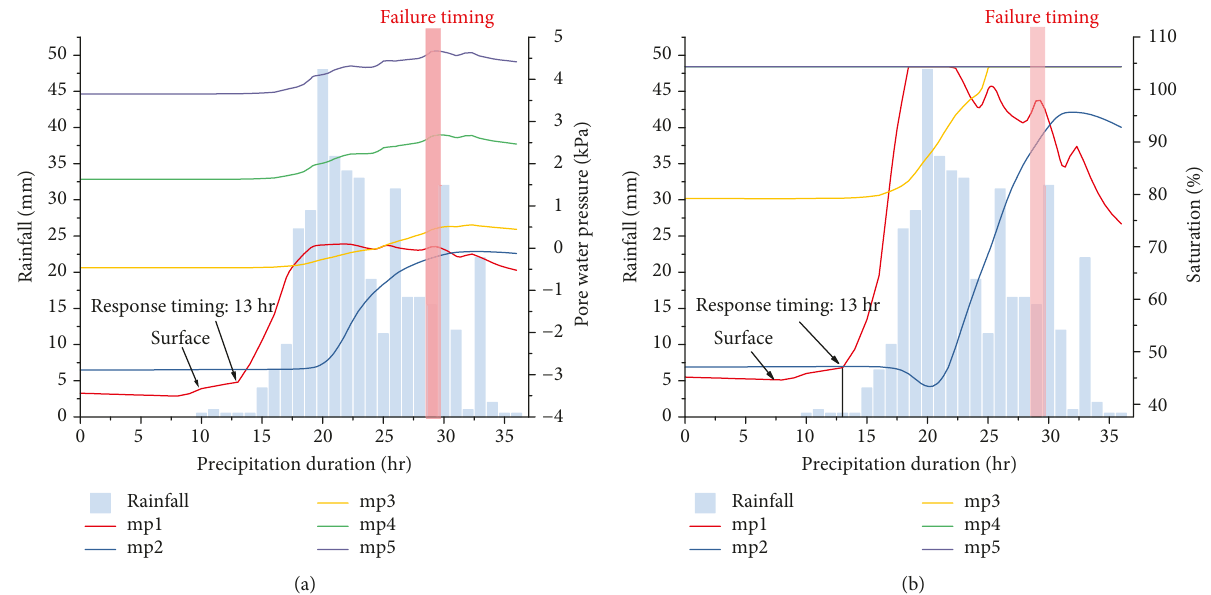
Figure 8: (a) The variation of the pore water pressure for monitoring points: mp1 – 5. (b) The variation of the saturation for monitoring points: mp1 –